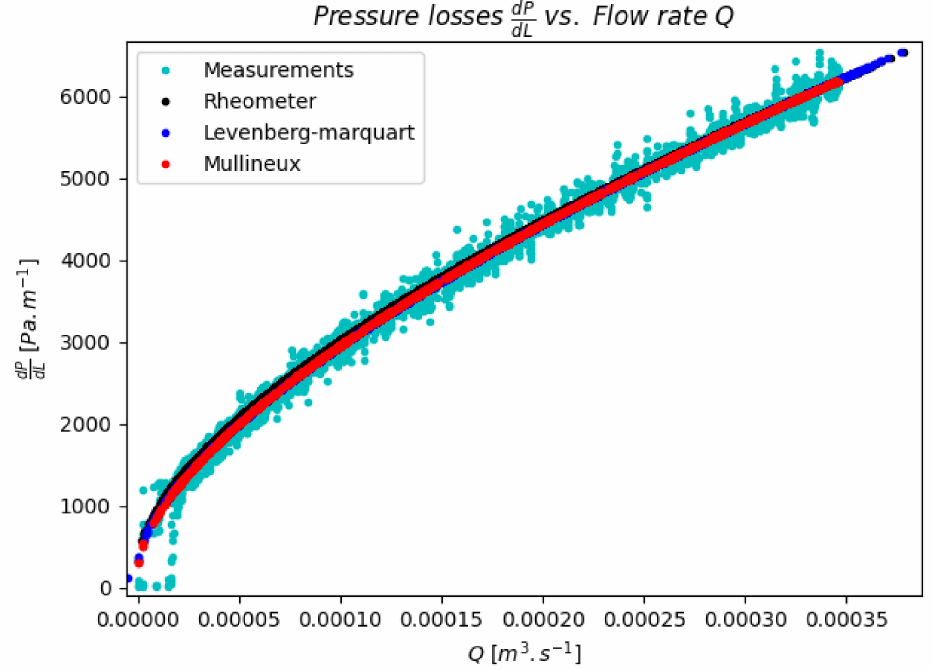
Figure 6. Measured and calculated pressure losses as a function of the flow rate. Curves named Rheometer, Levenberg-Marquart, and Mullineux are the result of a calculation using the H-B parame- ters estimated by the technique referring to their name and inverting Equation